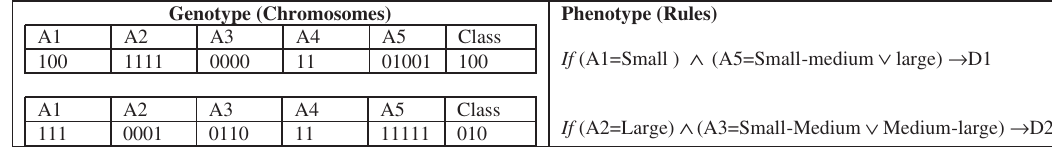
Figure 2: Encoding Scheme.